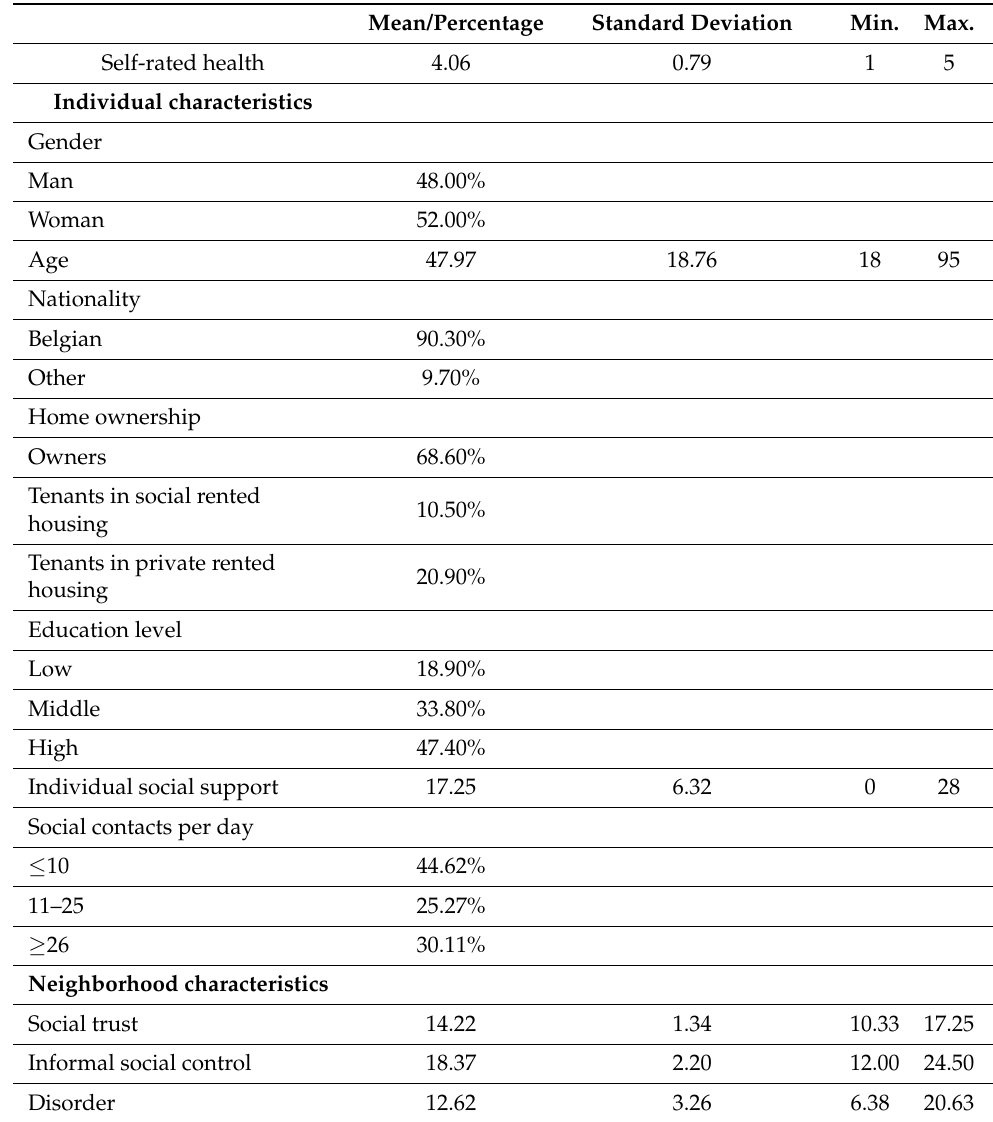
Table 1. Descriptive statistics ( N = 2730 respondents in N = 142